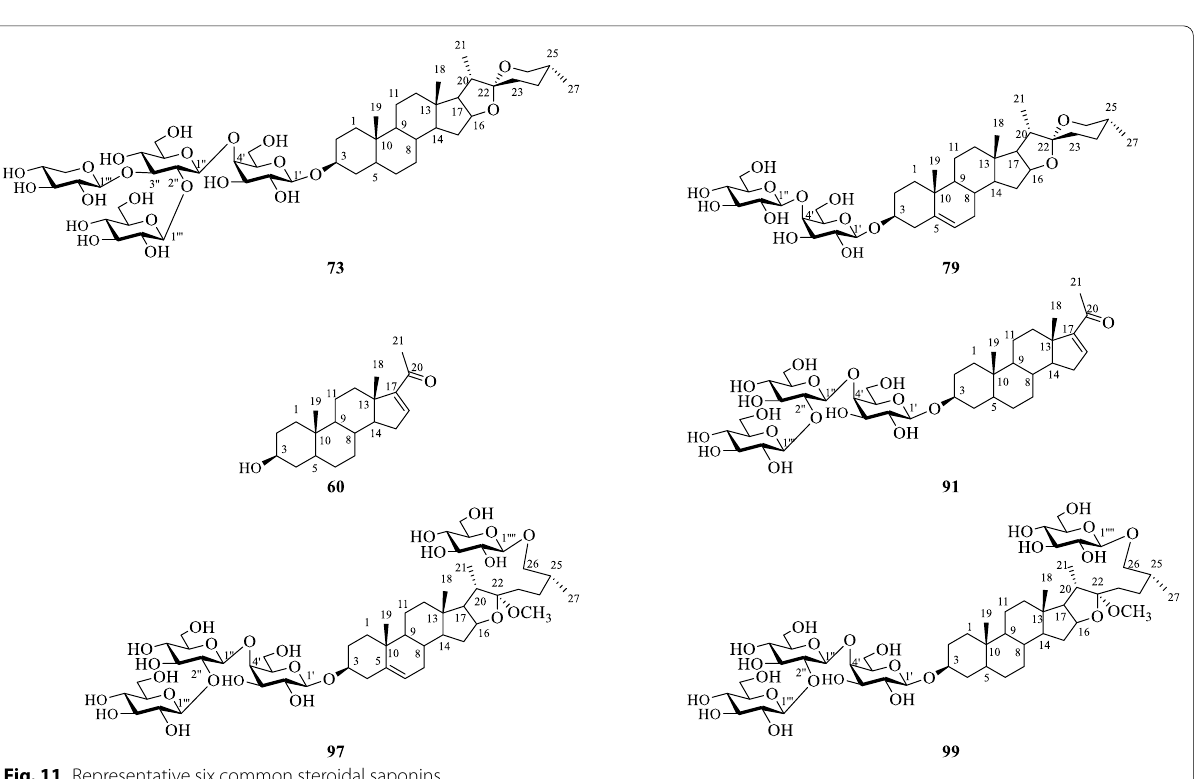
Fig. 11 Representative six common steroidal